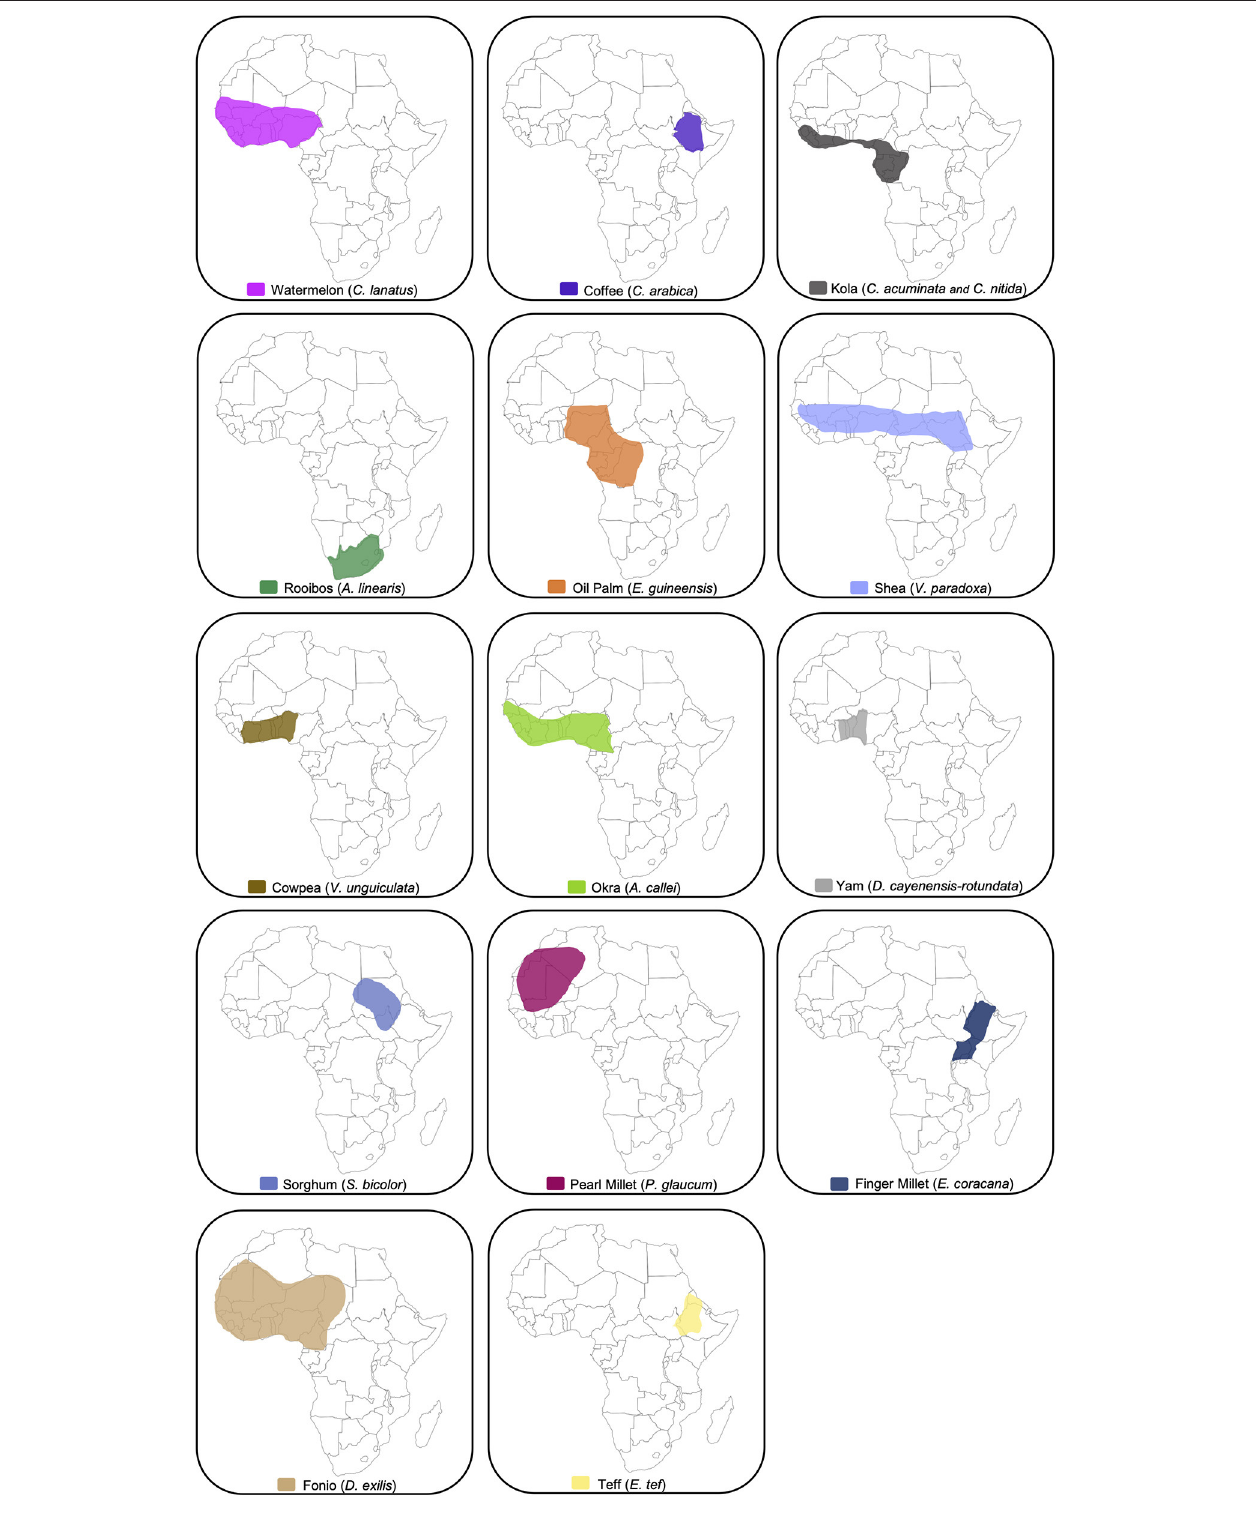
FIGURE 1 | Map showing the hypothesized centers of origin of African food crops. See main text for references.